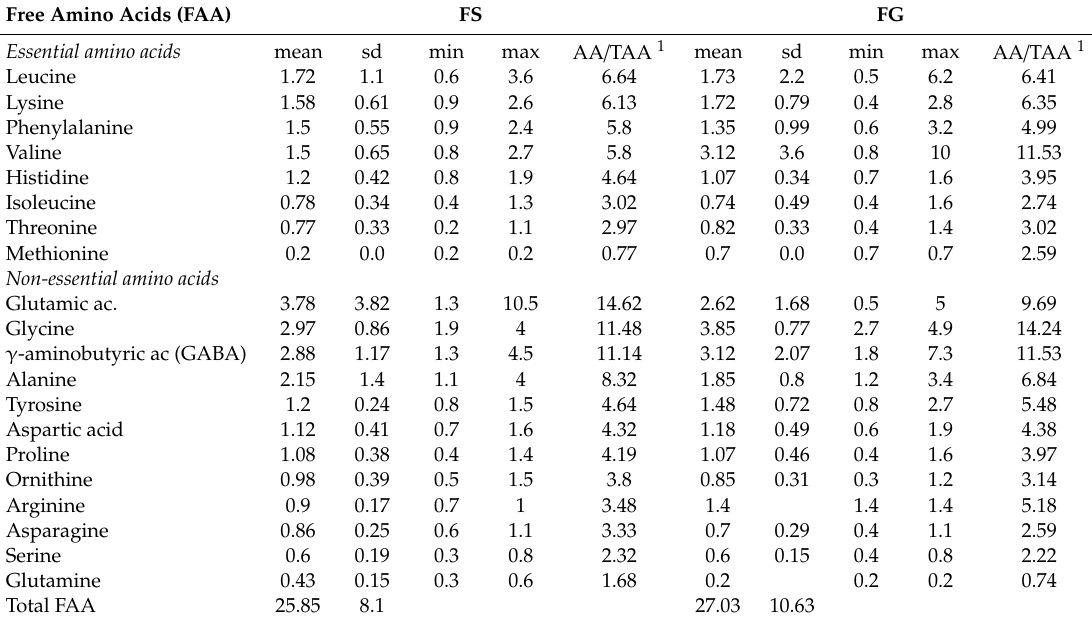
Table 3. Descriptive statistics of free amino acid content (mg / 100 g of cheese) in Fruhe cheese produced with sheep (FS) and goat milk